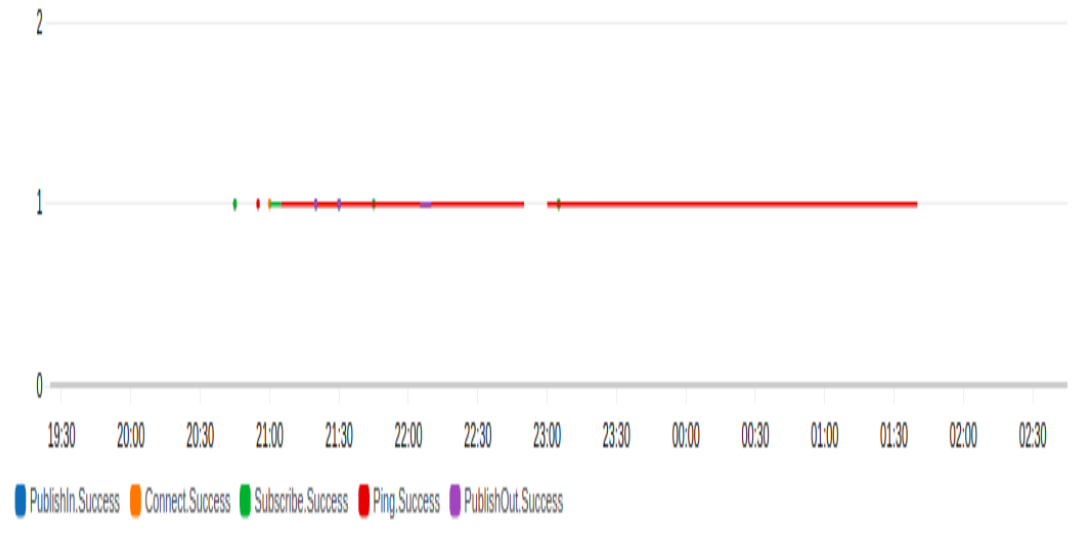
Figure 11. Successfully exchanged messages of di ff erent types: PublishOut.Success, PublishIn.Success, Connect.Success, Ping.Success, Subscribe.Success. The x-axis represents hours of the day, and the y-axis one day.